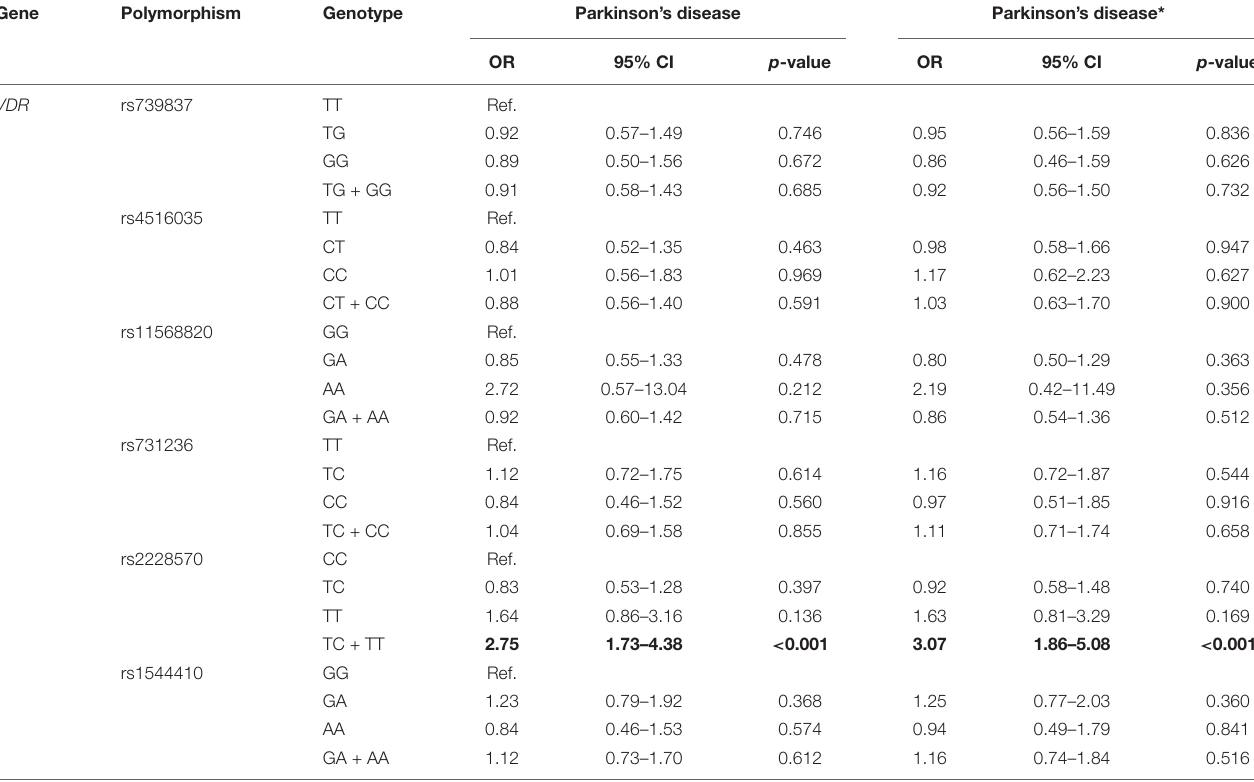
TABLE 3 | Associations between VDR genotypes and the risk for Parkinson’s disease. Gene